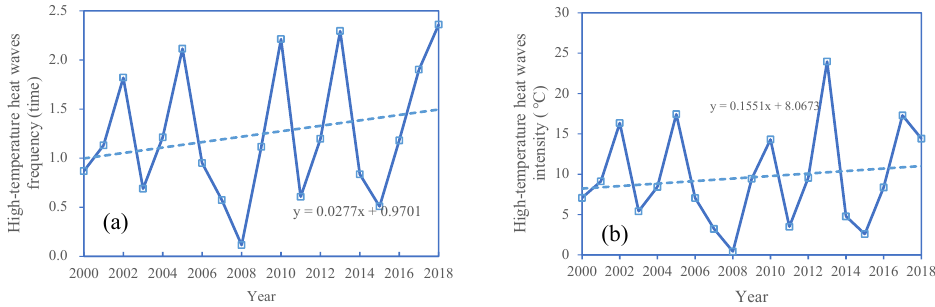
Figure 4. Temporal changes in the frequency ( a ) and intensity ( b ) of high-temperature heat waves in summer from 2000 to 2018. In the summer of 2000–2018, the frequency of high-temperature heat wave events in the North China Plain was higher in the west than in the east and higher in the south than in the north (Figure 5a), and the increase in the west was obvious (Figure 5c). Among the 62 meteorological stations, the frequency of high-temperature heats waves at Zhengzhou, Xinxiang, Heze and Dangshan stations increased significantly ( p < 0.05), while the fre- quency of heat waves at Shijiazhuang station showed a significant decreasing trend.